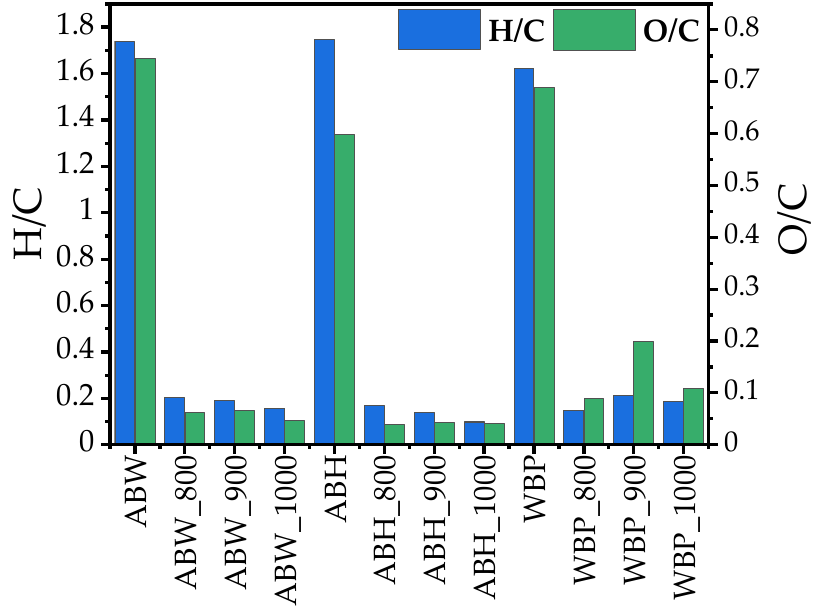
Figure 3. Hydrogen (H/C ratio) and oxygen (O/C ratio) indexes of the studied samples.